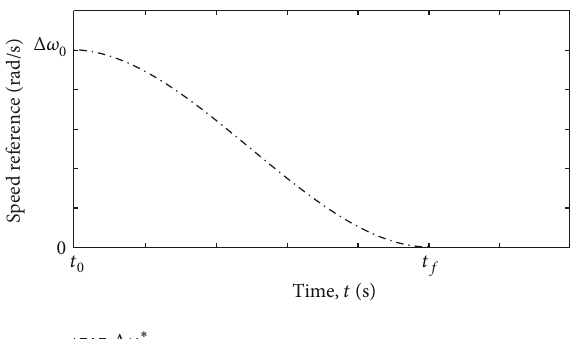
Figure 4: Reference trajectory of clutch slipping speed.